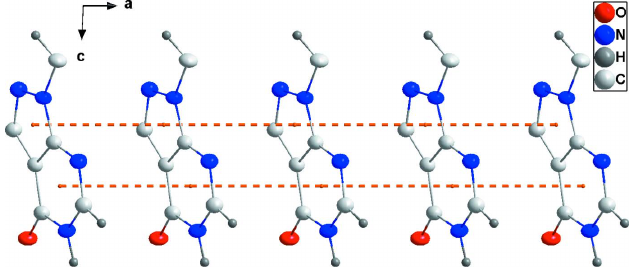
Figure 3 Detail of the (cid:2) -stacking interactions (dashed lines) leading to columns viewed along the b -axis direction